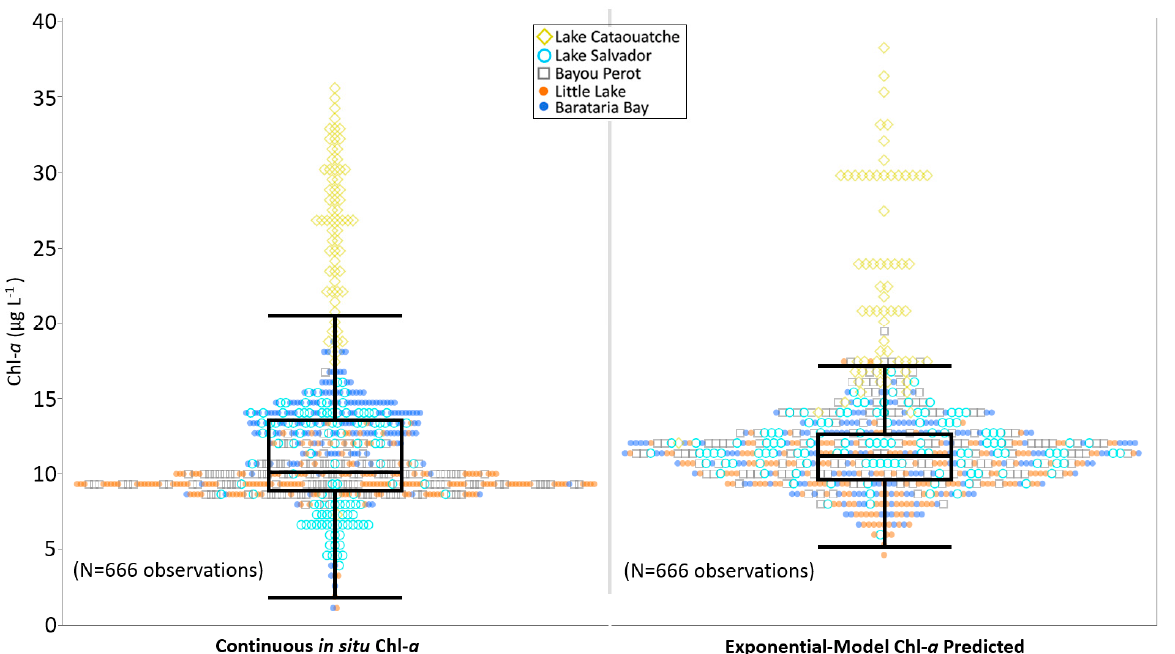
Figure 9. Mean [Chl- a ] (±SD) values for the continuous in situ Chl- a and the model-predicted data Chl- a using the exponential model ( α = 0.05).